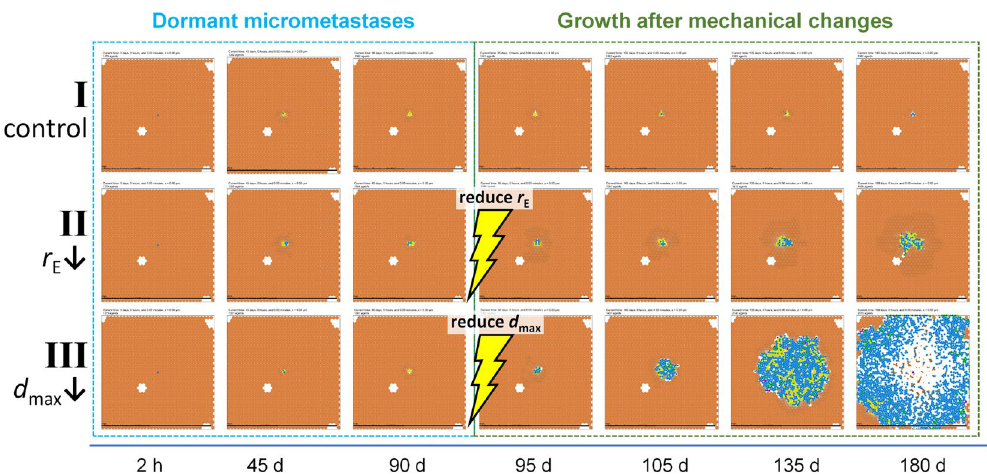
Figure 10. Dormant tumor reawakening after biomechanical changes: three micrometastases were grown to dormancy over 90 days in identical conditions and then subjected to biomechanical changes in the liver parenchyma before an additional 90 days of growth. Tumor I (control) remained dormant for the extra 90 days. Tumor II ( r E ) “reawakened” with slow growth. Tumor III (reduced tolerance to deformation d max ) reawakened to exhibit rapid growth. Cells are colored as described in Fig.